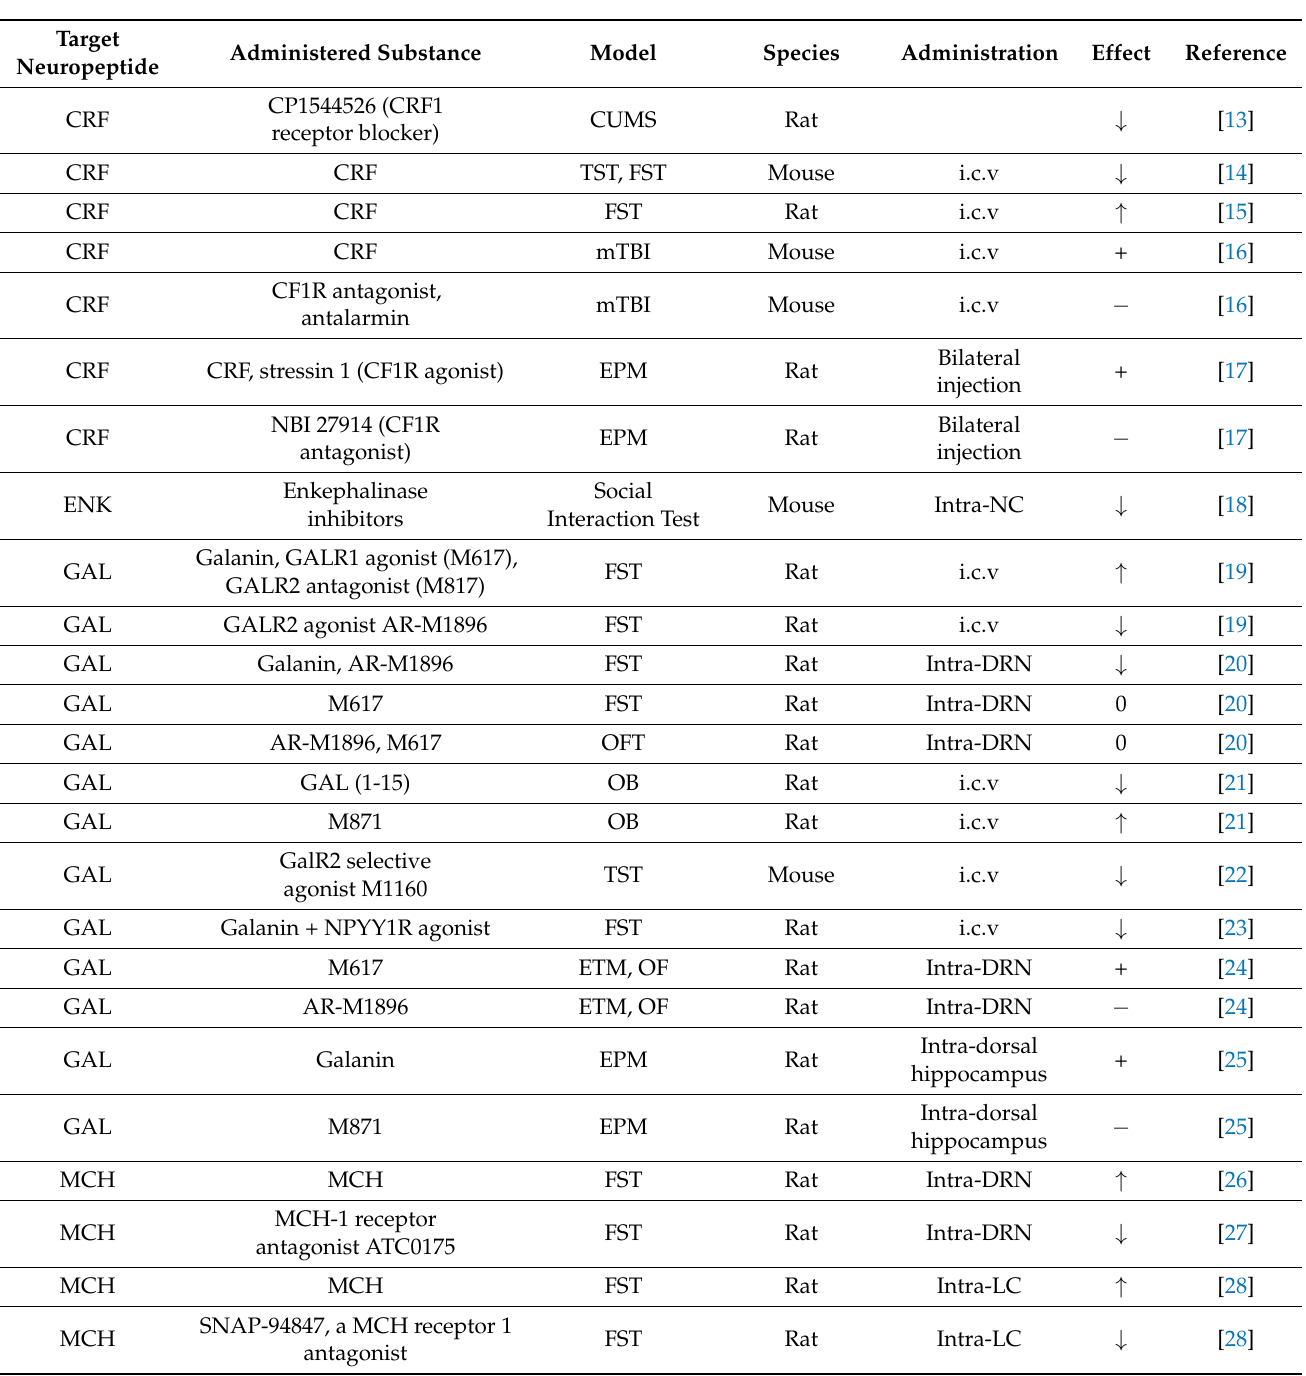
Table 1. Summary table classifying studies showing the effect of neuropeptides on depression and anxiety by model, species, and route of administration. 0: no effect; ↑ : pro-depressive effect; ↓ : antidepressant effect; +: anxiogenic effect; − : anxiolytic effect; SPS: single prolonged stress; FST: forced swimming test; CeA: central nucleus of amygdala; VCT: Vogel’s conflict test; CMS: chronic mild stress; EPM: elevated plus maze; OFT, OPF: open field test, OB: olfactory bulbectomy; TST: tail suspension test; NPY: neuropeptide Y; SP: substance P; NT: neurotensin; GAL: galanin; CRF: corticotrophin-releasing factor; OX: orexin; MCH: melanin-concentrating hormone; OT: oxytocin; ENK: